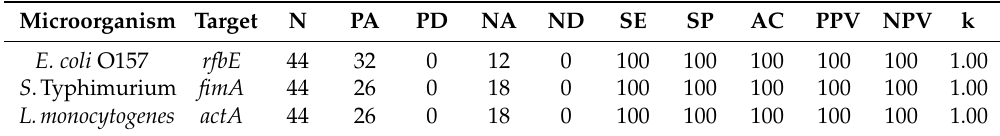
Table 5. Quality parameters from samples analysis.